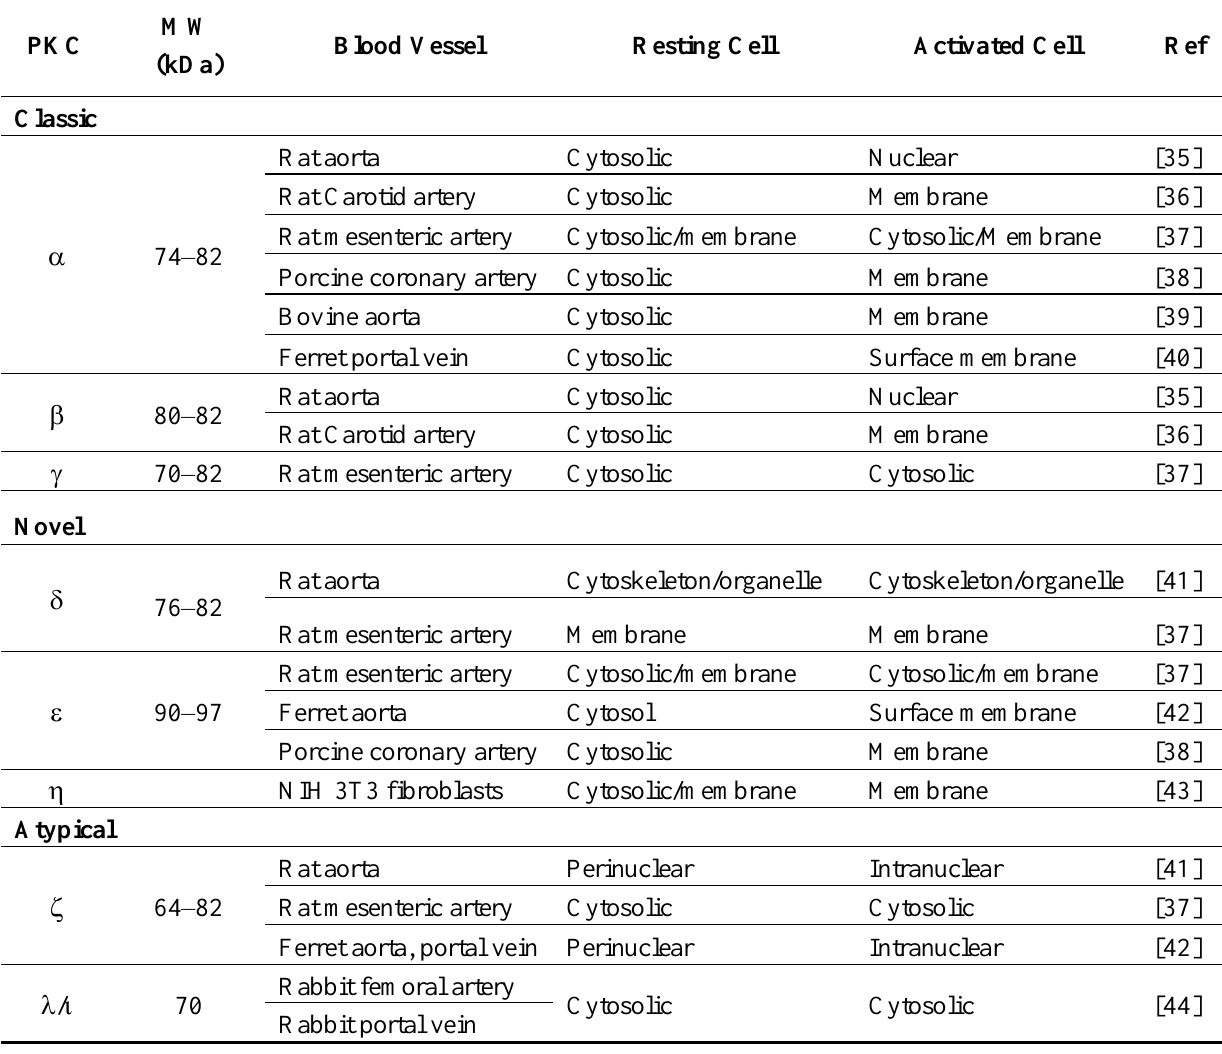
Table 1. Representative PKC Distribution and Subcellular Distribution in Blood